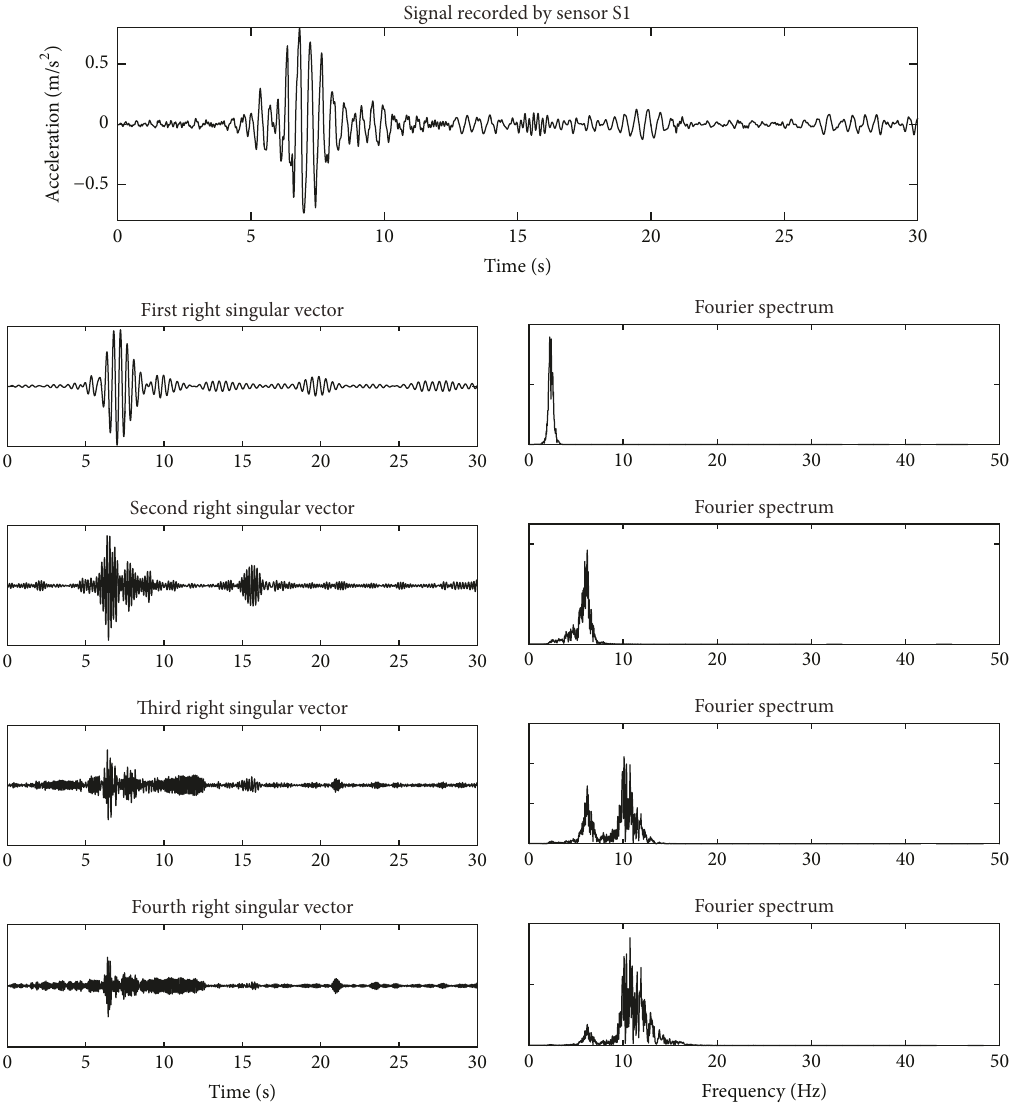
Figure 9: First four right singular vectors and their frequency